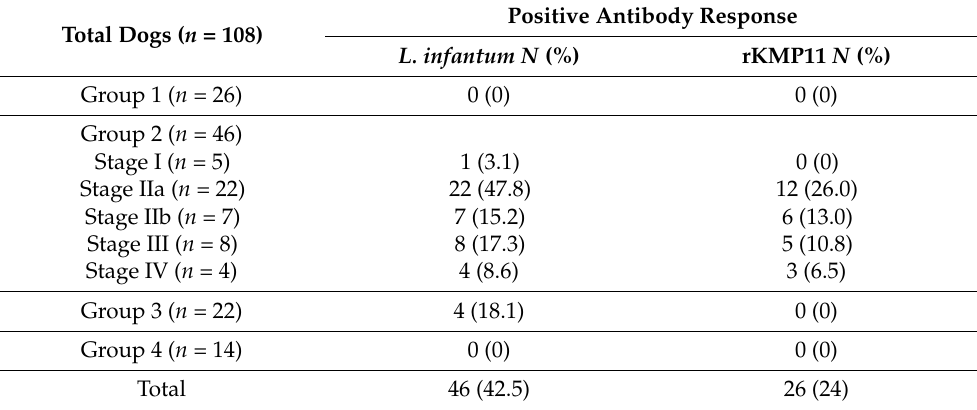
N = number of dogs by group positive to the test, % = percentage of dogs by group positive to the